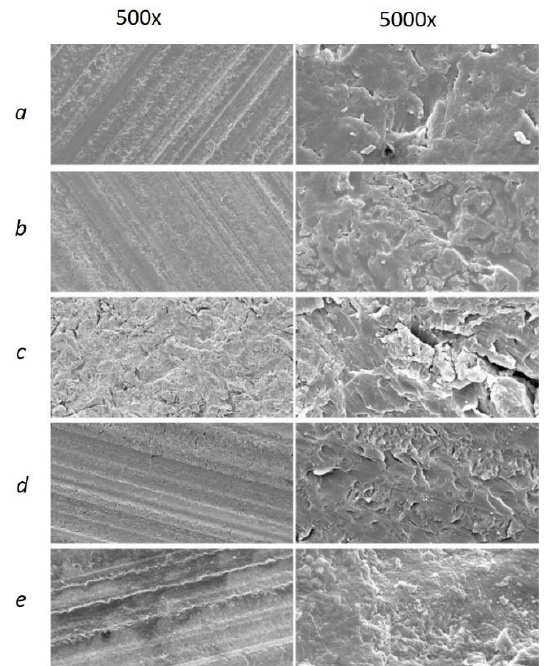
Figure 6. SEM images of Group A with 500× and 5000× magnification of reference ( a ), MMA ( b ), sandblasted ( c ), oxygen plasma ( d ), and nitrogen plasma ( e ) groups.